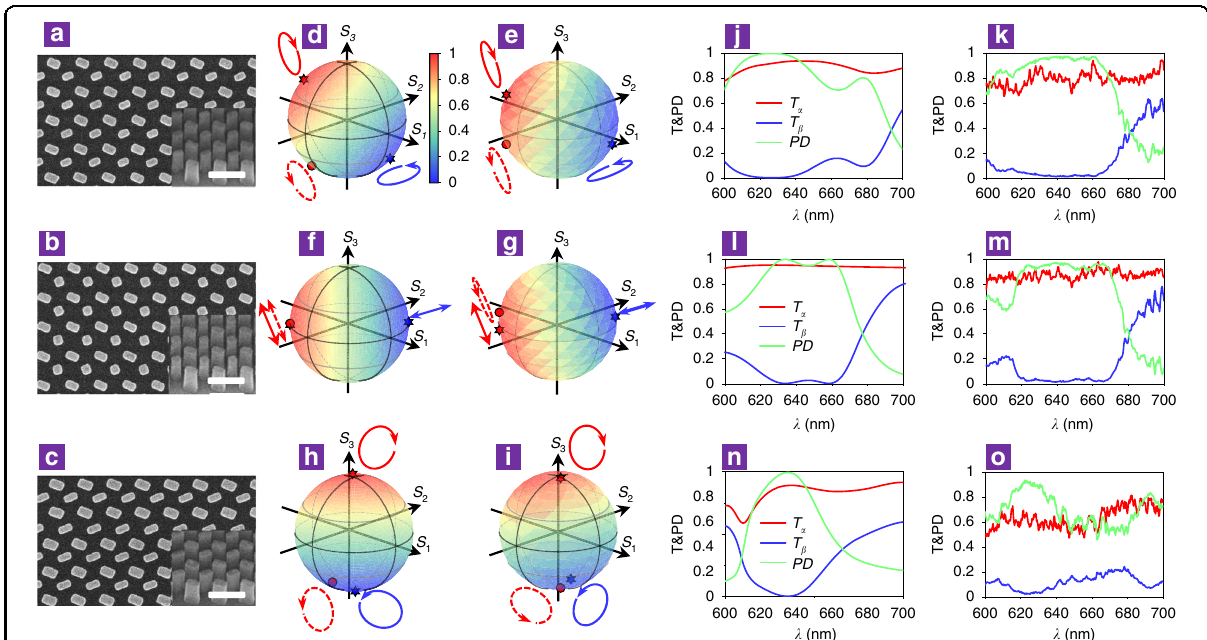
Fig. 3 Experimental demonstration of the elliptical, linear and circular polarization conversion dichroism. a – c SEM images of the dichroism metasurfaces for different ellipticities, including ( a ) elliptical, ( b ) linear and ( c ) circular polarization states; the scale bar is 400 nm. The sizes ( l 1 , w 1 , l 2 , w 2 ) of the two nanopillars are (130nm, 70 nm, 150 nm, 85 nm), (95 nm, 95 nm, 145 nm, 80 nm) and (160 nm, 75 nm, 165 nm, 100 nm) for a , b and c , respectively. d – i Simulated and measured transmittances of all possible polarizations covering the full Poincaré sphere through the d, e elliptical, f, g linear and h, i circular dichroism metasurfaces. The red and blue stars represent the polarization states with maximum and minimum transmittance depicted as red and blue ellipses, respectively. The dots represent the transmitted polarization states denoted as dashed ellipses. j – o Simulated and measured transmission spectra and dichroism spectra for j, k elliptical, l, m linear and n, o circular dichroism